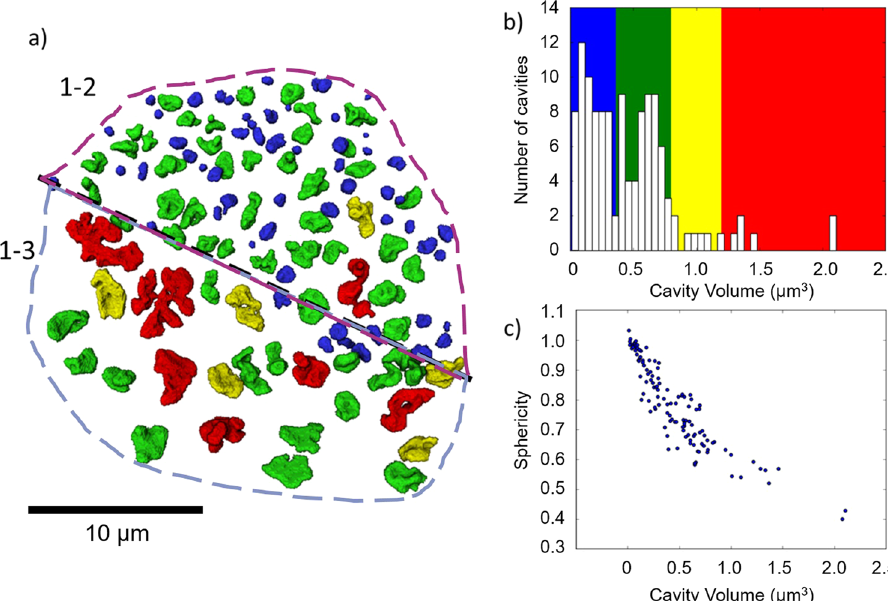
Figure 3. ( a ) Volume rendering from X-ray nanotomography data showing the presence of cavities at grain boundaries 1–2 and 1–3 with colour mapping based on the volume of cavities. ( b ) Histogram of cavity volumes displaying the colour map associated with the volume rendering in ( a ). ( c ) Scatter plot of sphericity of cavities vs